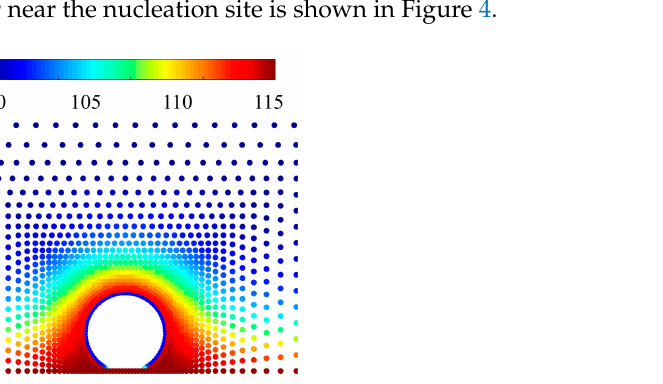
Figure 4. Temperature distribution of the superheated liquid layer near the nucleation site when nucleation starts.